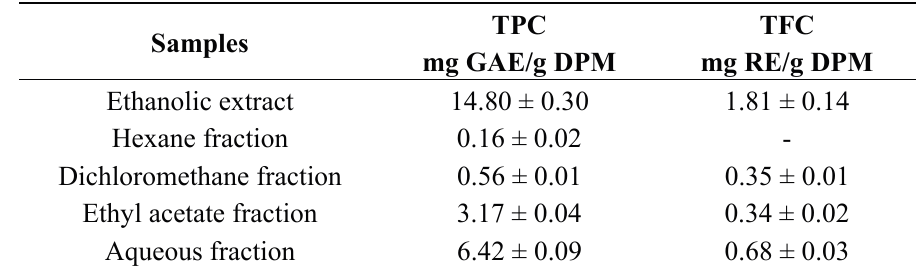
Table 2. Total phenolic and flavonoid contents in ethanolic extract and fractions of Mimosa caesalpiniifolia stem